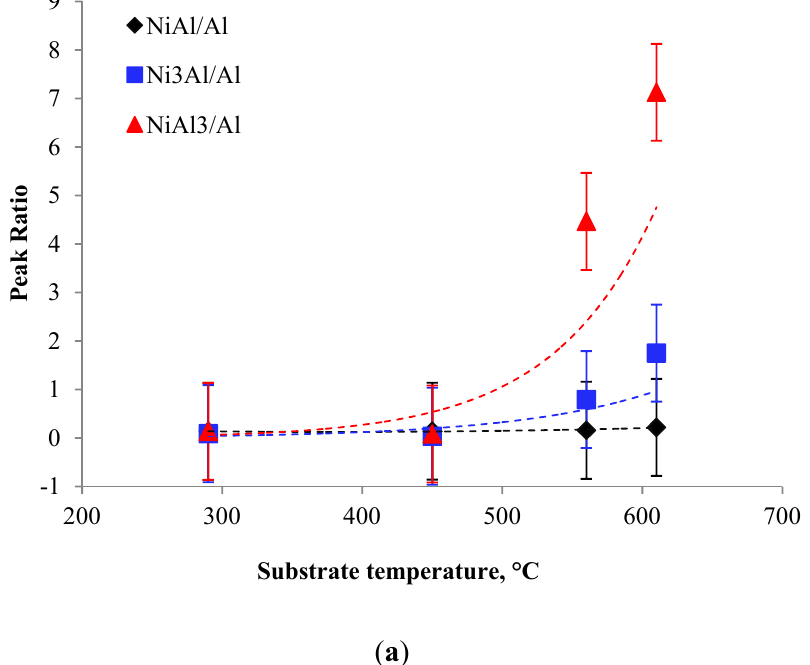
Figure 5. Influence of ( a ) substrate temperature and ( b ) ratio O composition of the